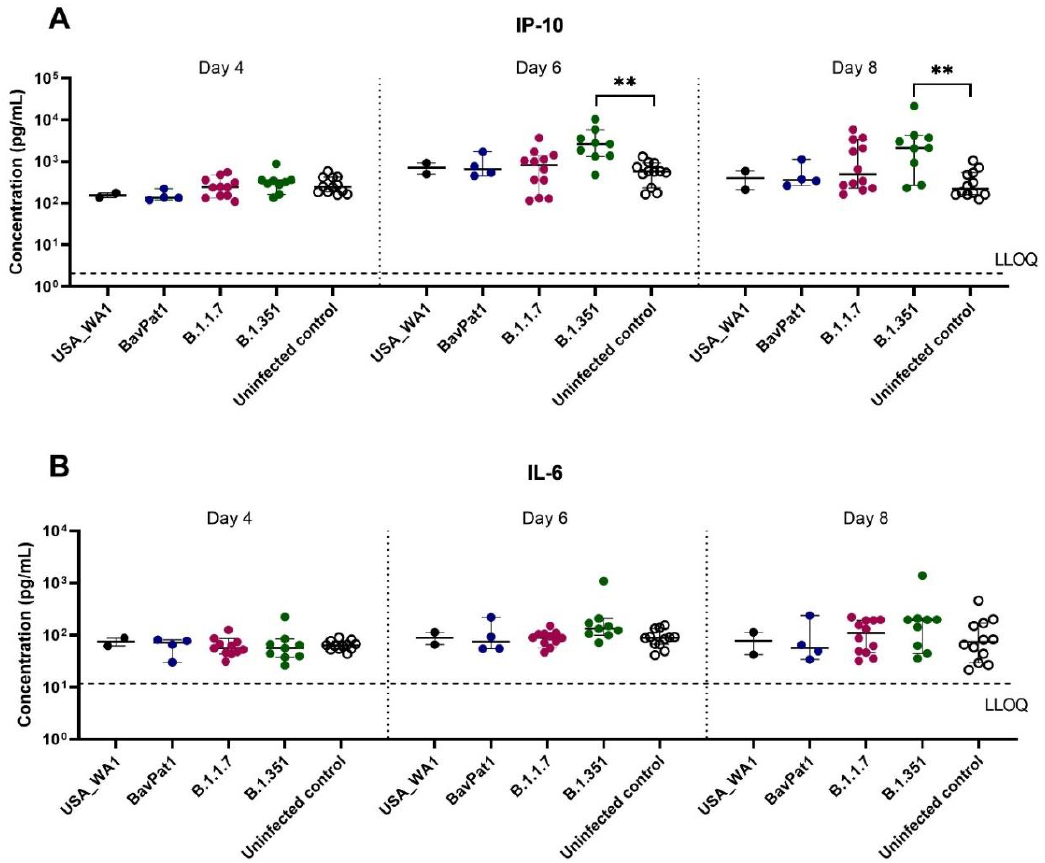
Figure 3. Cytokine and chemokine expression profiles after infection of HsAEC with different SARS- CoV-2 isolates. Production of ( A ) IP-10 or ( B ) IL-6 in HsAEC post-infection in the presence or absence of SARS-CoV-2. For this analysis, the infected samples from two experiment samples were pooled. The dotted lines represent the lower limit of quantification (LLOQ). Statistical significance between variants and uninfected control was calculated by Kruskal–Wallis with two-sided Dunn’s post hoc test. ** p < 0.01.